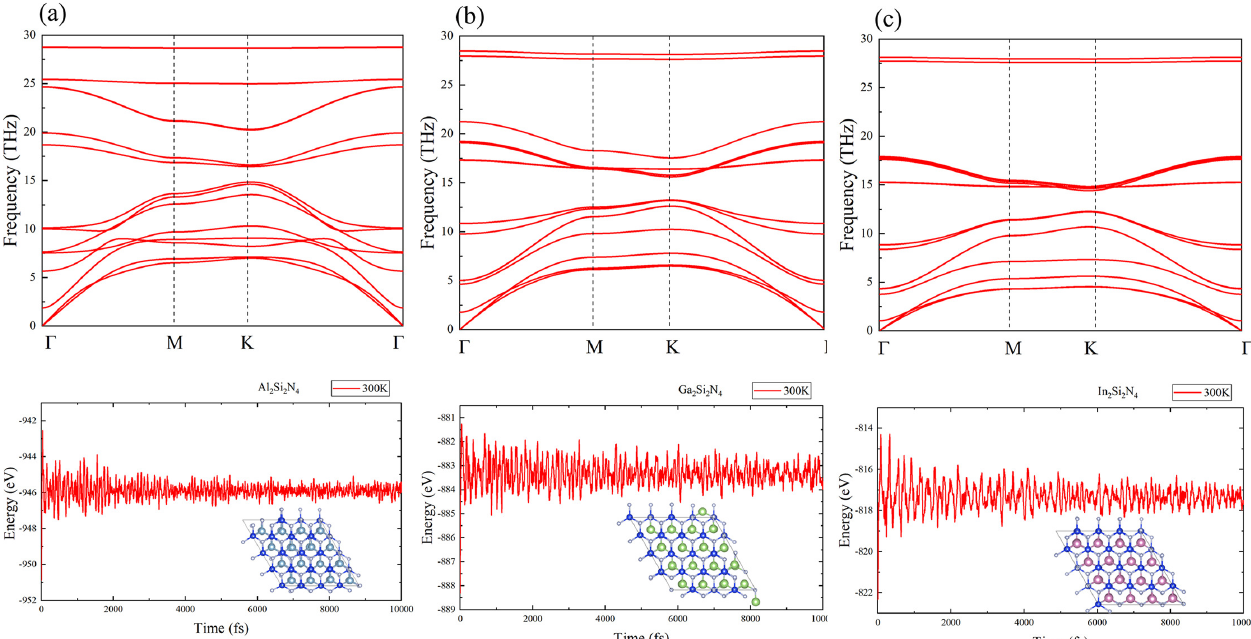
Figure 2. The phonon spectra and energy variations under the AIMD simulations at 300 K of